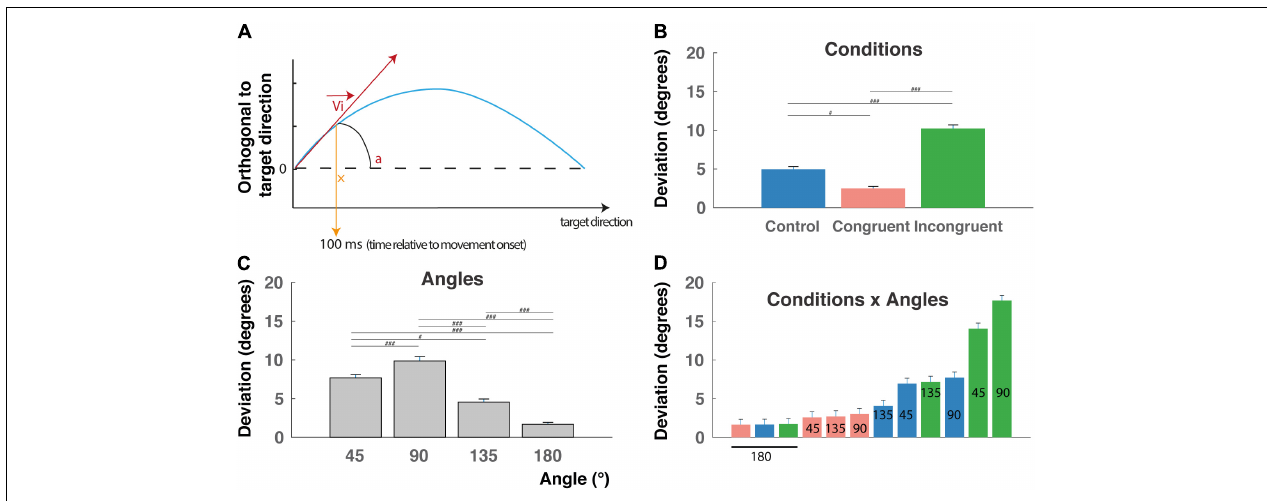
FIGURE 3 | Initial deviation (ID). (A) The initial deviation (ID) corresponds to the angular difference between the initial direction computed 100 ms after the movement onset and the overall direction determined as the center of the target location. It indicates the decision made early after movement onset. Blue line: reach trajectory. Red arrow: initial direction. (B) ID for incongruent trials are significantly longer than control and congruent trials RTs and congruent trials are faster than control trials ( ### P < 0.0001) indicating that the interference and congruency effects are found also after movement onset. (C) ID decrease with the angular distance between targets, except for the 90 ◦ angular separation. (D) Almost linear increase of RT when considered the (12) conditions x angles trial types and revealing a continuum in the competition level induced by these trials-types also after movement onset (but see text for peculiarity of the 90 ◦ and 180 ◦ angular distances). # p < 0.01.